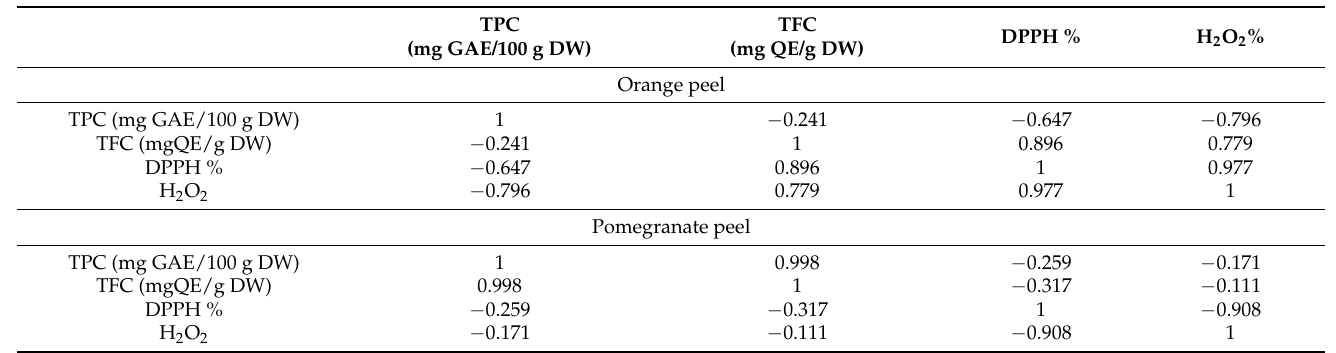
Table 11. Correlation matrix between polyphenol composition or antioxidant activity of orange and pomegranate peel.